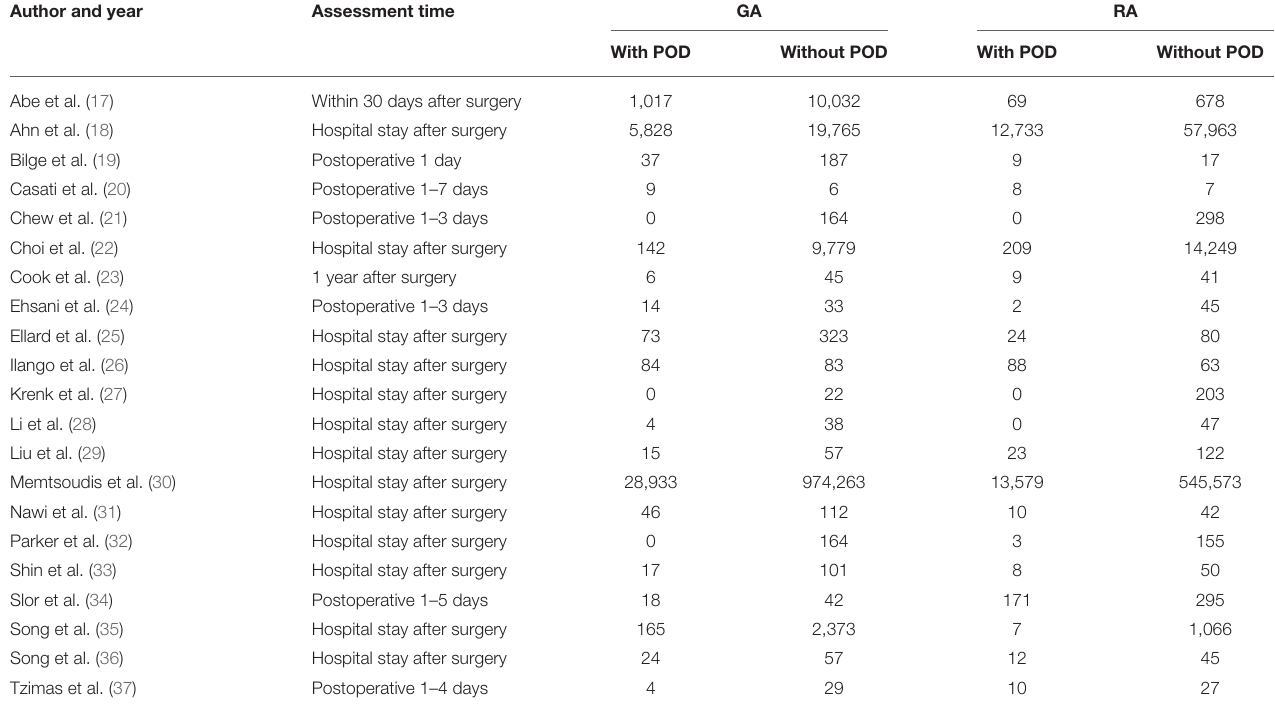
TABLE 2 | The follow-up time and number of patients with POD under different anesthesia modes. Author and